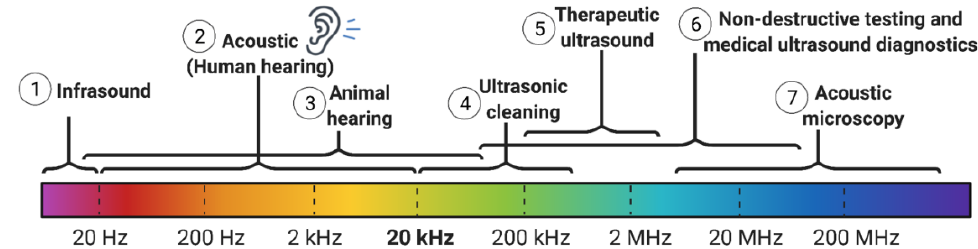
Figure 2. The spectrum of ultrasound with respect to audible sound and different frequency ranges for diagnostic versus therapeutic applications. (Created with for diagnostic versus therapeutic applications. (Created with BioRender.com).